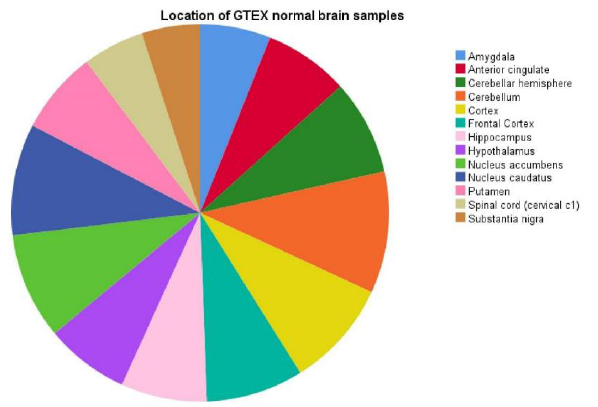
Figure 4. Illustration demonstrating the different locations of normal brain tissue samples from the GTEx database.